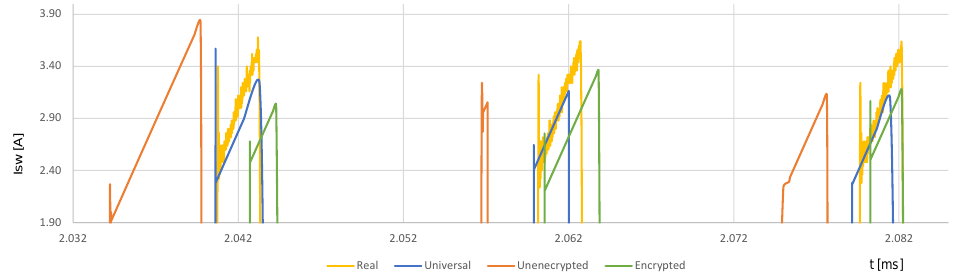
Figure 17. Detailed I sw models and real measurement time graph curves.